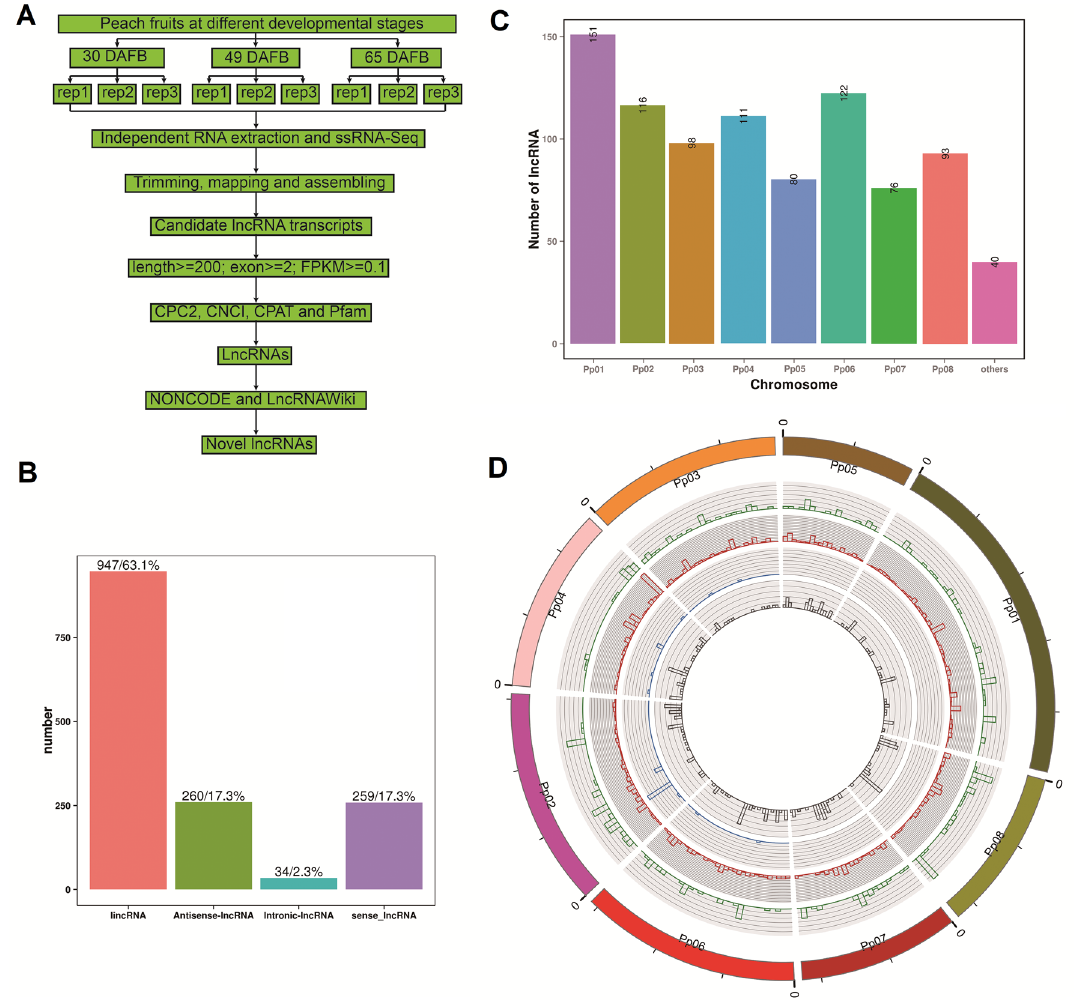
Figure 1. Characteristics of lncRNAs identified in peach fruits. ( A ) The pipeline used to identify novel lncRNAs from ssRNA-seq data. ( B ) Classification of identified lncRNAs based on the relative locations of lncRNAs and related genes. ( C ) Distribution of lncRNAs on different chromosomes. ( D ) Circos plot shows the overall distribution of four types of lncRNAs in the genome. Tracks from outside to inside are sense lncRNAs, lincRNAs, antisense lncRNAs and intronic